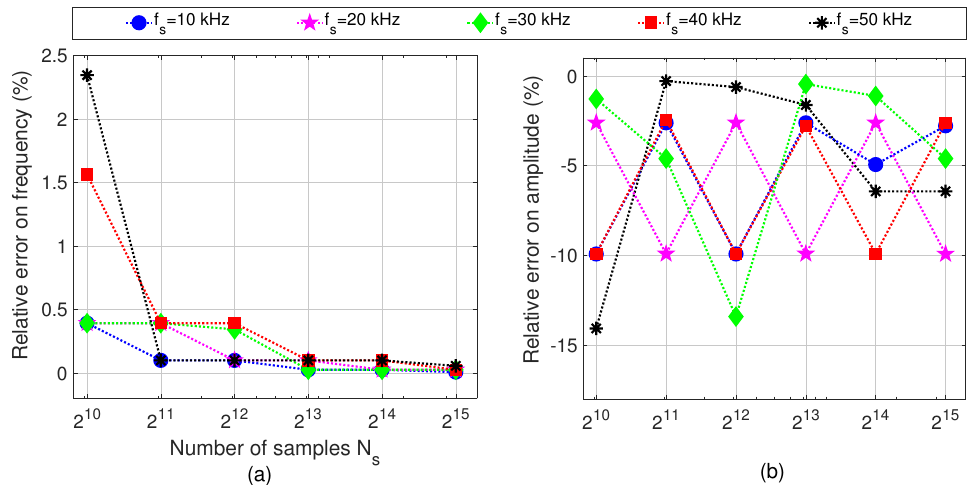
Figure 6. Relative error affecting the ( a ) fundamental frequency and ( b ) amplitude of the input sinusoidal signal, when the order 2 Hann window is